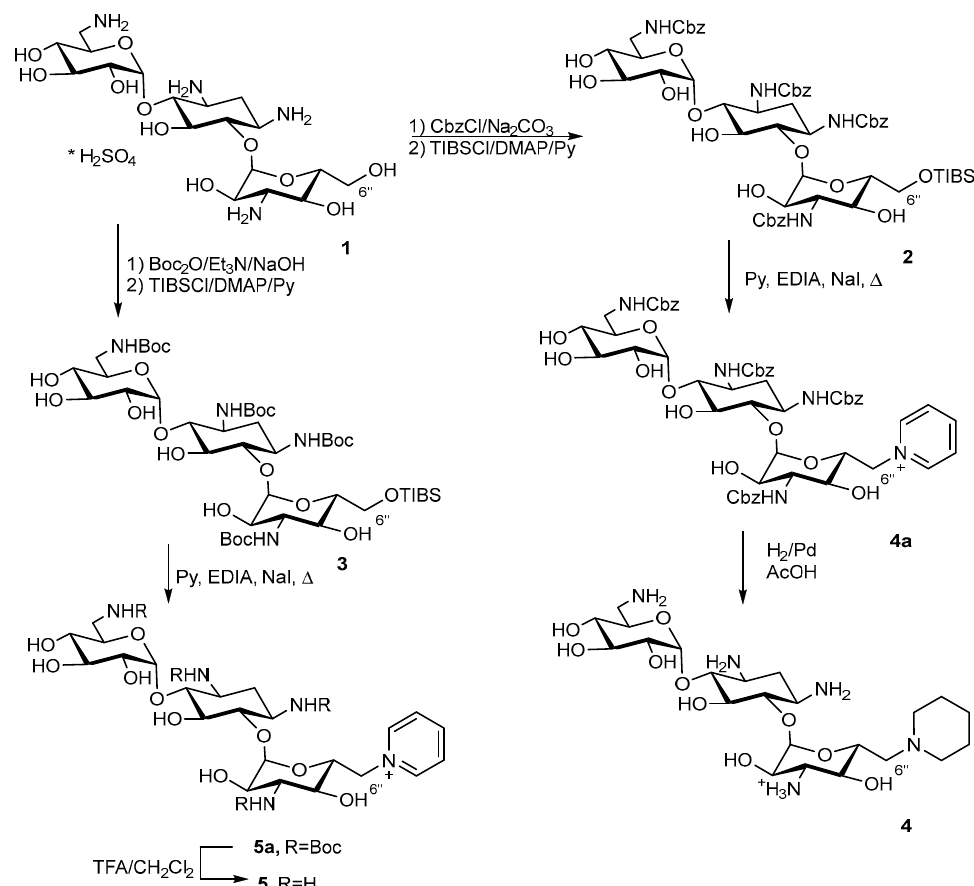
Scheme 2. Synthesis of 6 ″ -modified KANA derivatives 6 – 8